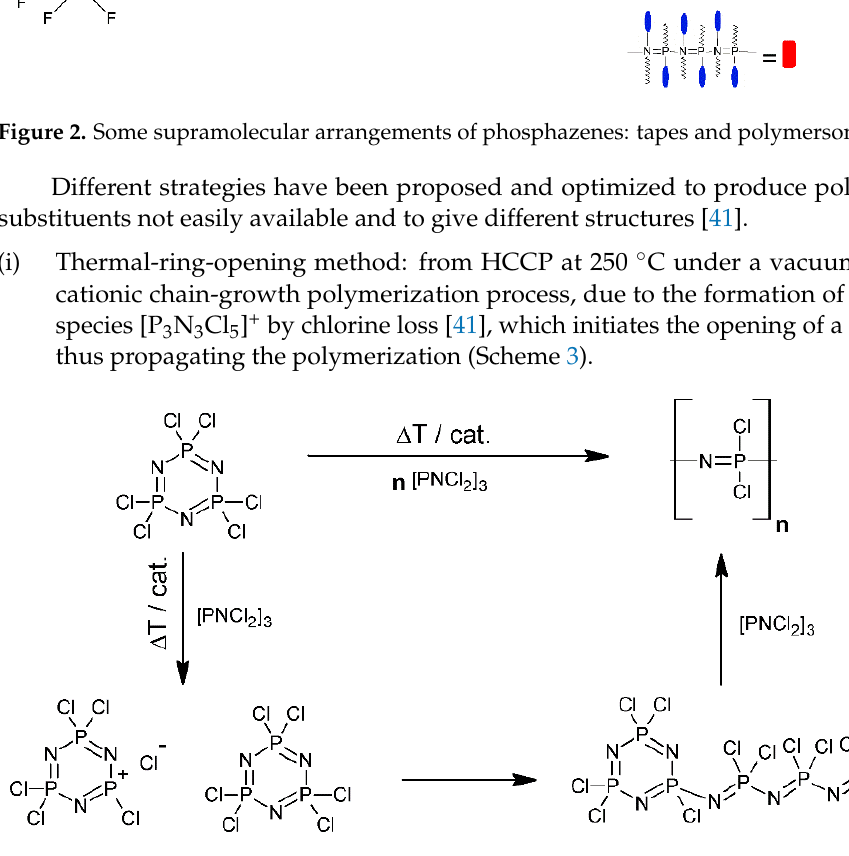
Scheme 3. Proposed mechanism for the cationic chain–growth polymerization